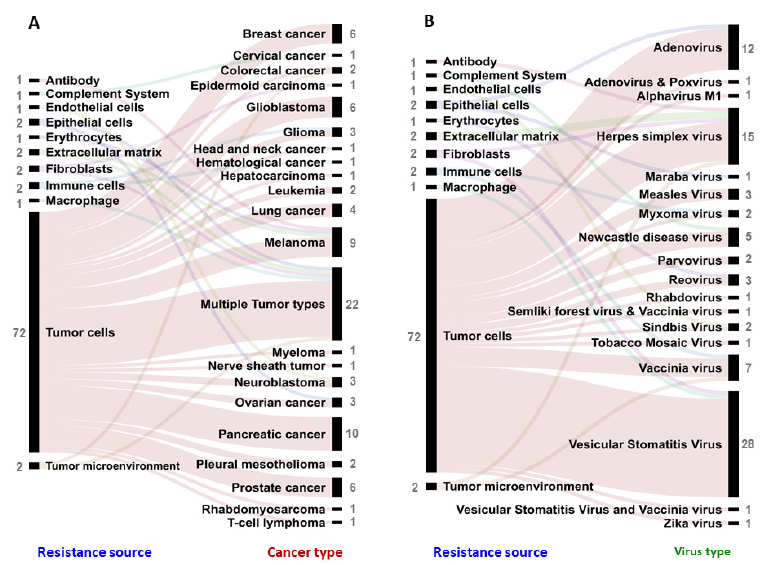
Figure 4. Resistance to oncolytic virotherapy exhibited by different sources or cell types present in the tumor microenvironment. Resistance source assessed in research articles in the context of ( A ) different cancers and ( B ) different virotherapy platforms. Each link indicates an article. The number of articles studying a particular resistance source, cancer type, and virus type is indicated next to the label in